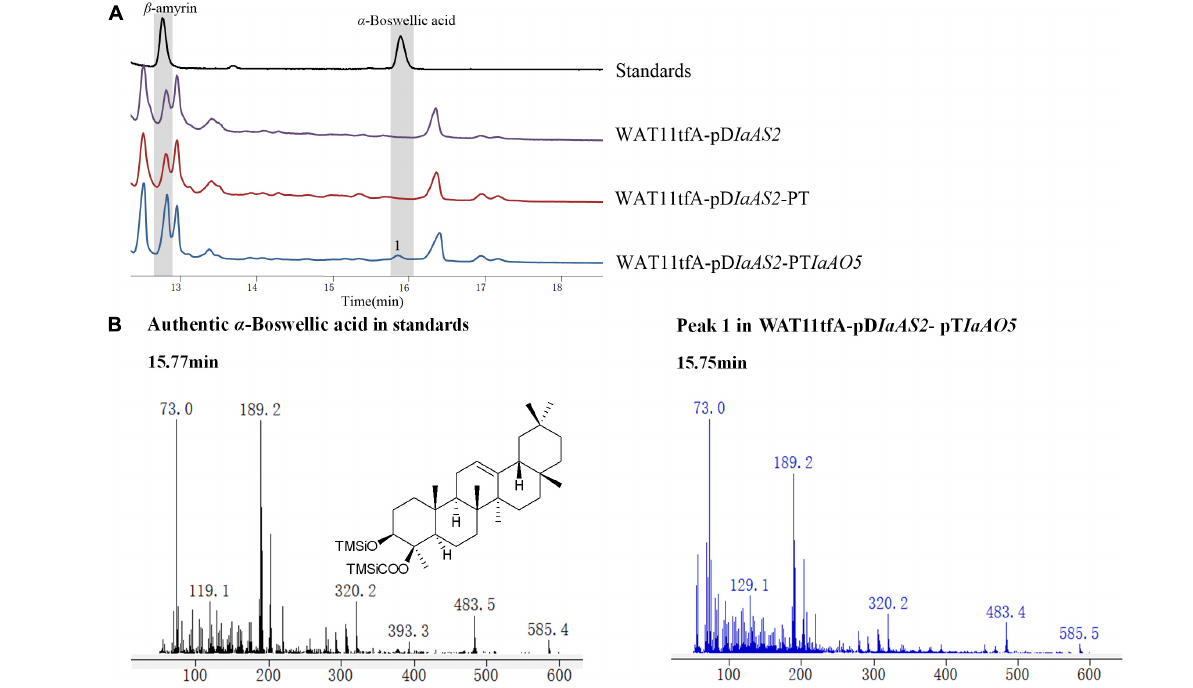
FIGURE 6 | GC-MS analysis of metabolites in WAT11tfA-pD IaAS2 -pT IaAO5 . (A) Total ion chromatograms of mixed standard (black line), WAT11tfA-pD IaAS2 (purple line), WAT11tfA-pD IaAS2 -pT (red line), and WAT11tfA-pD IaAS2 -pT IaAO5 (blue line). Major peaks were numbered. (B) Mass spectrum of α -Boswellic acid and peak 1 from the GC profile shown in panel (A) . The retention time and mass spectra of peak 1 compared well with those of α -Boswellic